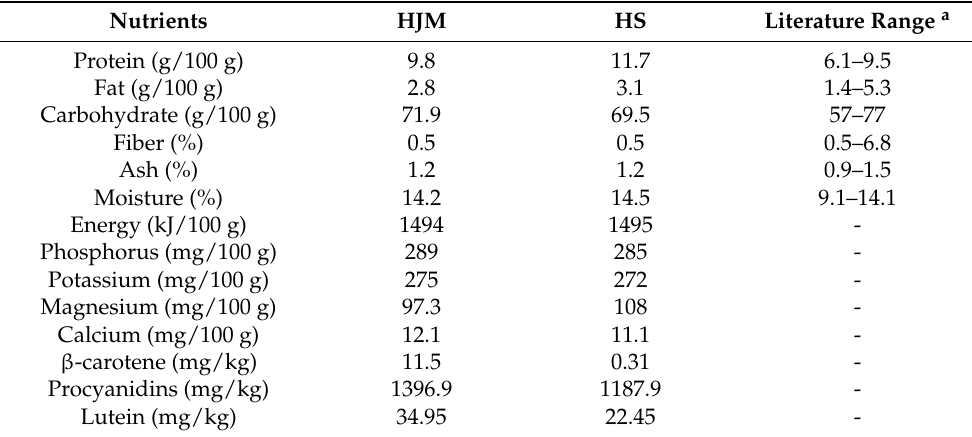
Table 1. Nutritional components of HJM and